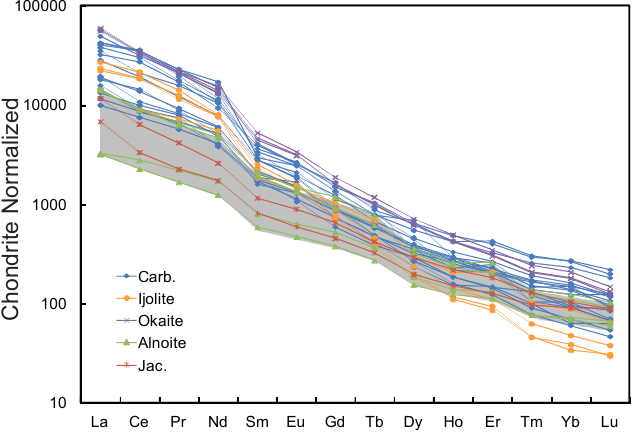
Figure 9. Chondrite normalized REE patterns for apatite from different rock types at Oka. As with Figure 8, additional REE abundances for apatite from carbonatite, okaite and melanite ijolite are from Chen and Simonetti [14]. The grey shaded area outlines the normalized patterns for apatite from alnöite and jacupirangite. Chondrite values are from McDonough and Sun [55].